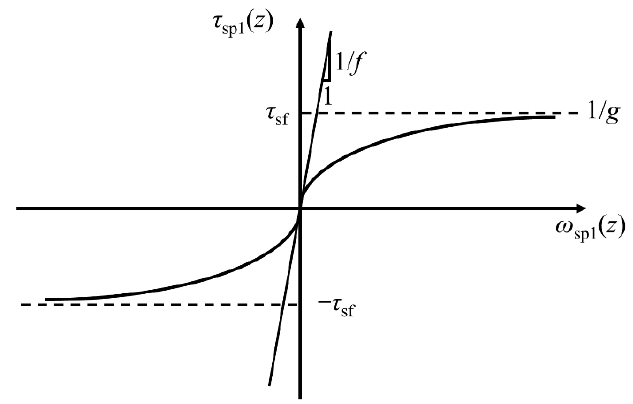
Figure 3. Hyperbolic load-transfer curve for pile shaft during excavation unloading. Table 1. Suggested value of K / K 0 and δ . Suggested Values Pile-soil Condition Smooth steel pipe piles or